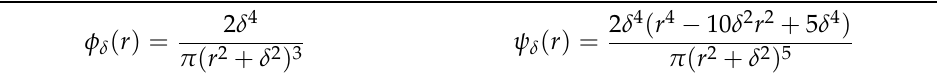
Table 1. Summary of regularizing functions. The blob φ δ ( r ) satisfies only the condition that its integral be one. The function ψ ( r ) satisfies two more conditions for higher accuracy as described in example